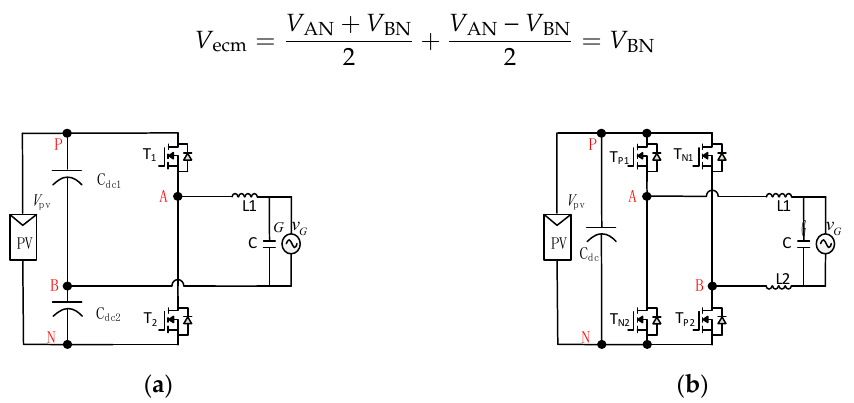
Figure 1. Topologies of ( a ) half-bridge inverter; and ( b ) full-bridge inverter (named H4).